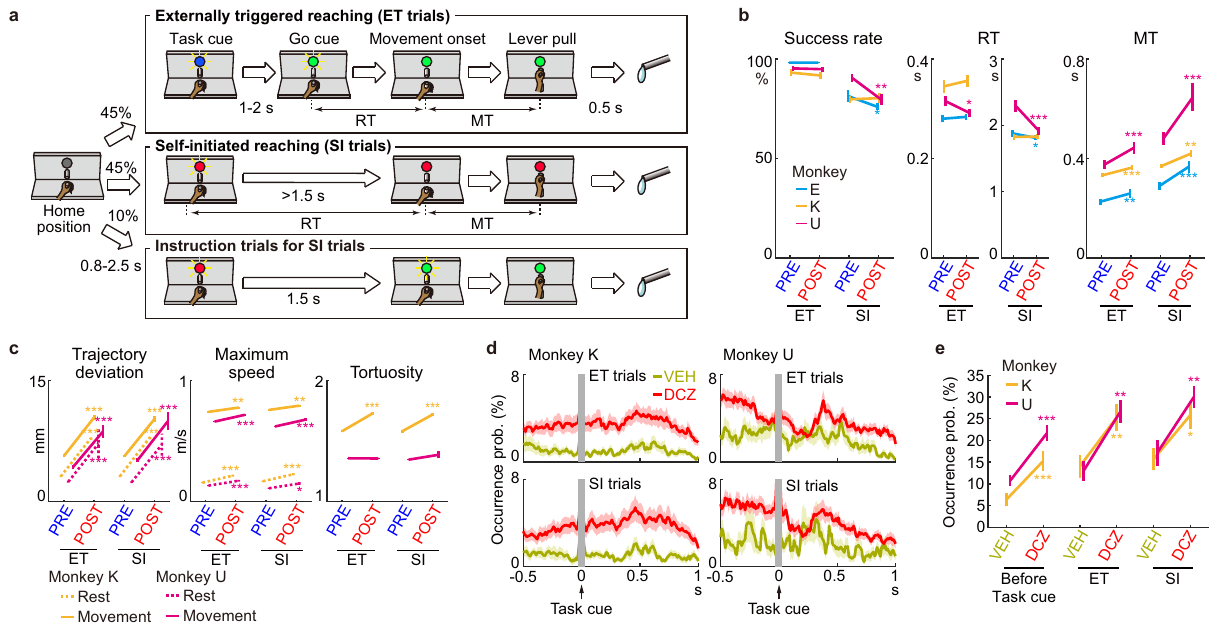
Fig. 2 Motor effects of reduction of STN activity on performance of a reach-and-pull task. a Custom reach-and-pull task. RT, reaction time; MT, movement time. b Task performance using the hand contralateral to the AAV injection side before (PRE) and after (POST) DREADD ligand administration (14, 15, and 20 sessions in monkeys E, K, and U, respectively). Success rate decreased in SI trials ( P = 0.02 and 0.001, monkeys E and U, respectively; two- tailed Wilcoxon-signed rank test), RT decreased in ET (0.01, U) and SI (0.02 and 0.0003, E and U), and MT increased in ET (0.007, 6 × 10 − 5 , and 0.0007; E, K, and U) and SI (0.0001, 0.001, and 0.0002; E, K, and U). c Analyses of wrist trajectories (179 ET and 155 SI trials in monkey K, and 101 ET and 103 SI in U). The following parameters signi fi cantly increased: Trajectory deviation during Rest (ET trials, P = 4 × 10 − 48 and 1 × 10 − 13 , monkeys K and U, respectively; SI trials, 2 × 10 − 41 and 4 × 10 − 14 ; two-tailed Mann – Whitney U -test) and Movement (ET, 4 × 10 − 40 and 1 × 10 − 15 ; SI, 2 × 10 − 29 and 2 × 10 − 9 ), Maximum speed during Rest (ET, 4 × 10 − 8 and 3 × 10 − 5 ; SI, 3 × 10 − 6 and 0.02) and Movement (ET, 0.003 and 1 × 10 − 9 ; SI, 0.003 and 1 × 10 − 6 ), and Tortuosity (ET, 1 × 10 − 16 , K; SI, 4 × 10 − 10 , K). d , e Occurrence of involuntary movements during the POST period with the VEH (31 and 18 sessions in monkeys K and U) or DCZ (43 and 41) administration. Solid lines and shading indicate mean ± SEM with 1-ms bin ( d ). Statistical analysis during the 0.5 s preceding (Before Task cue) and 1 s following Task cue (ET and SI) between VEH and DCZ ( e ). Involuntary movements increased during Before Task cue ( P = 0.0006 and 0.0002, monkeys K and U; two-tailed Mann – Whitney U -test), ET (0.007 and 0.006), and SI (0.03 and 0.003). Error bars indicate